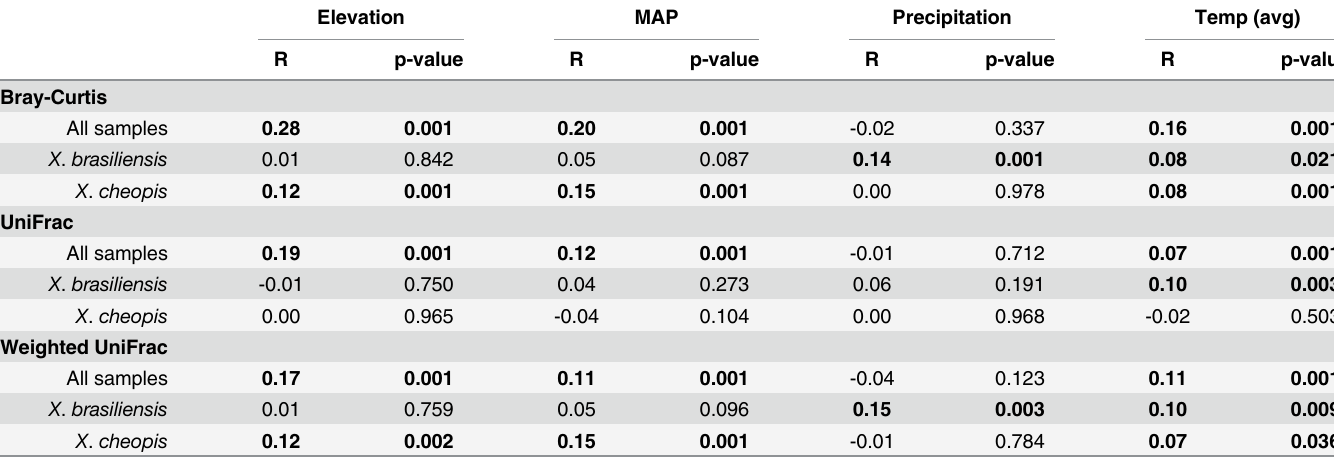
Table 6. Mantel Tests comparing bacterial community structure to environmental